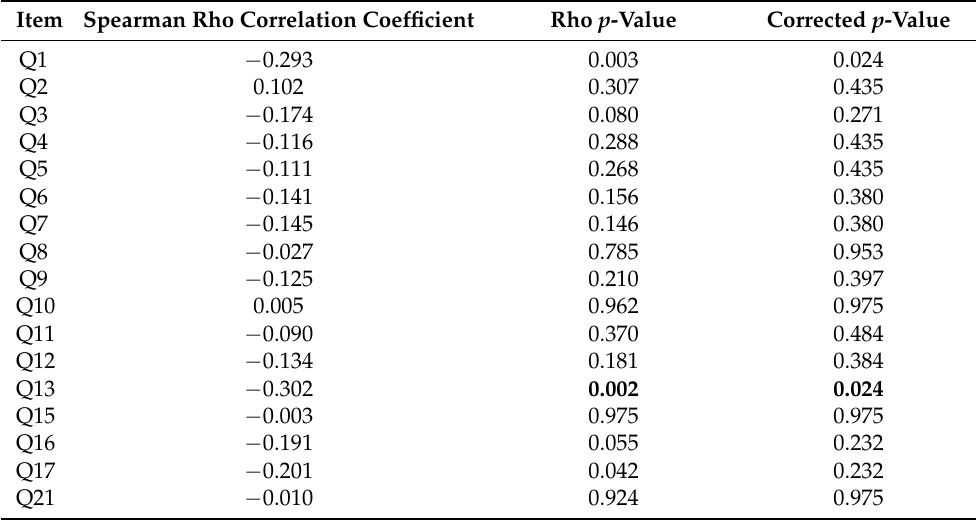
Table 8. Correlation between professors’ years of experience and the questionnaire items. Item Spearman Rho Correlation